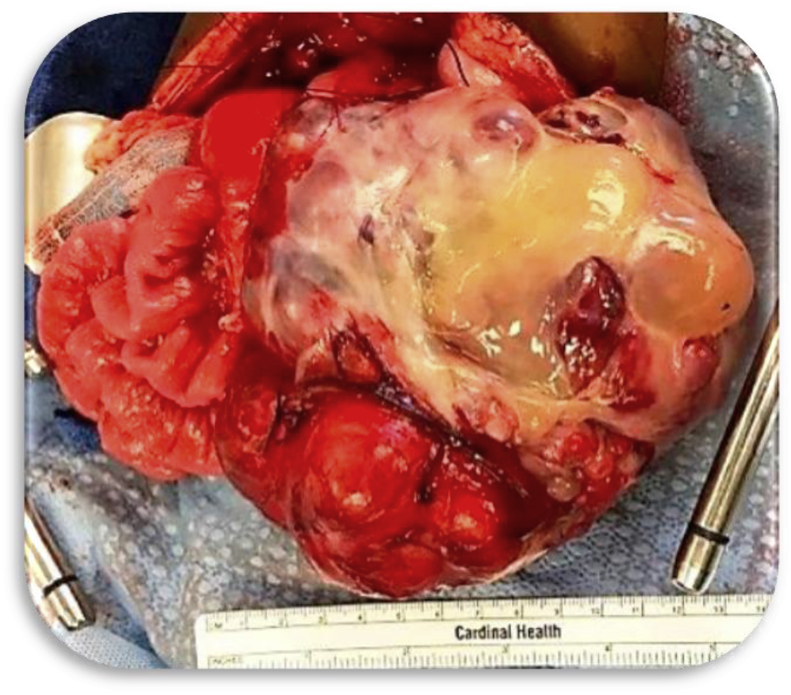
Operative specimen.